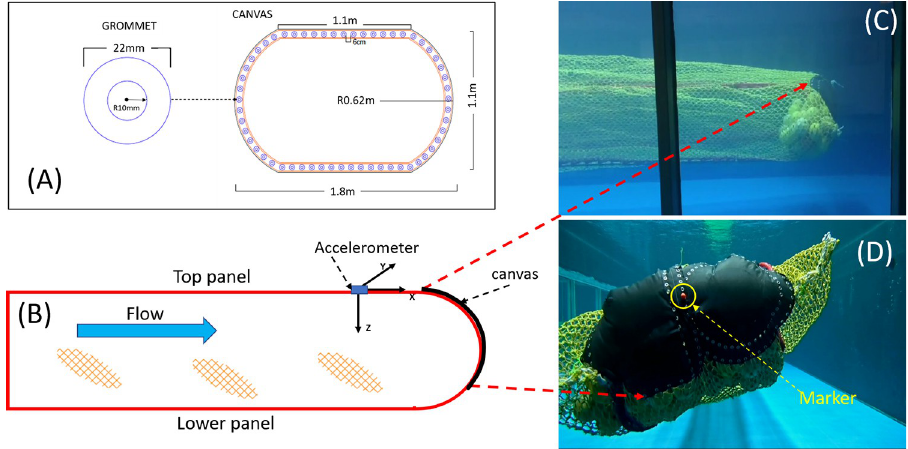
Fig 1. Canvas specification and location on codend. (A) detailed plan of canvas; (B) side-profile schematic illustration of the anterior section of the codend; (C) side-profile photo of the anterior section of the codend during flume tank tests; and (D) photo of the posterior of the codend during flume tank tests.